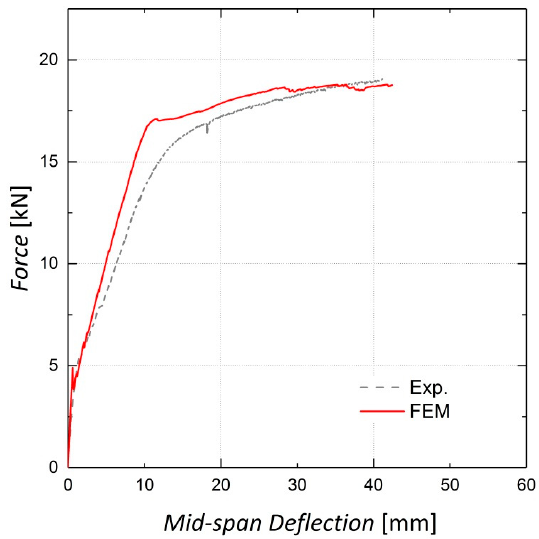
Figure 16. Finite Element analysis results for Beam 9 (non-prestressed).